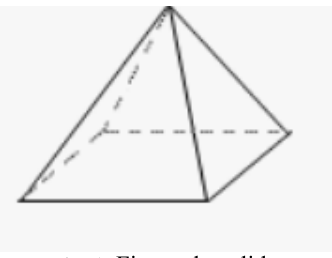
Fig. 1. Figure du solide.